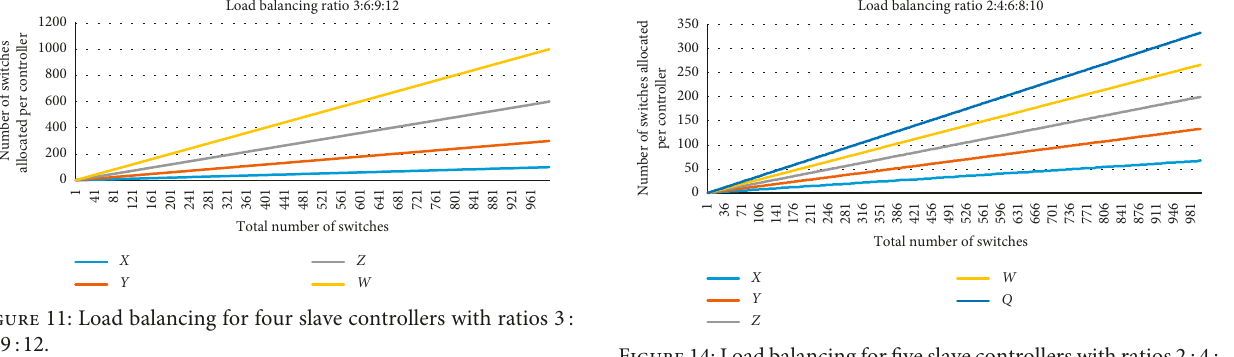
Figure 14: Load balancing for five slave controllers with ratios 2 :4: 6:8 :10.